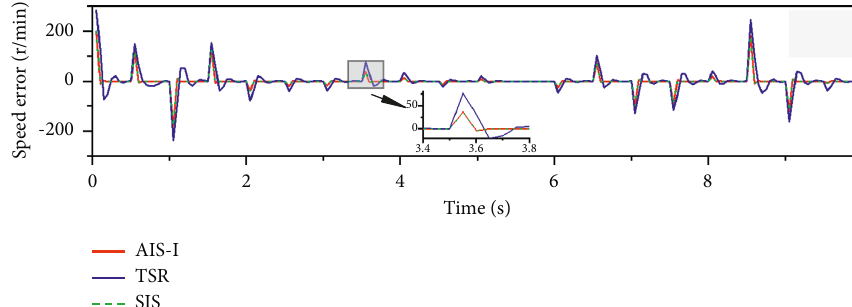
Figure 9: Simulated error between speed response and reference speed.